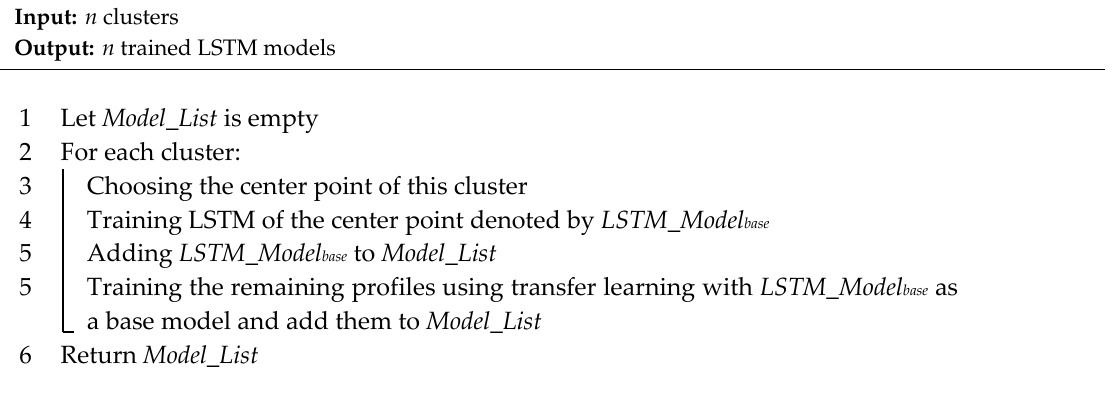
Algorithm 1. MEC training algorithm